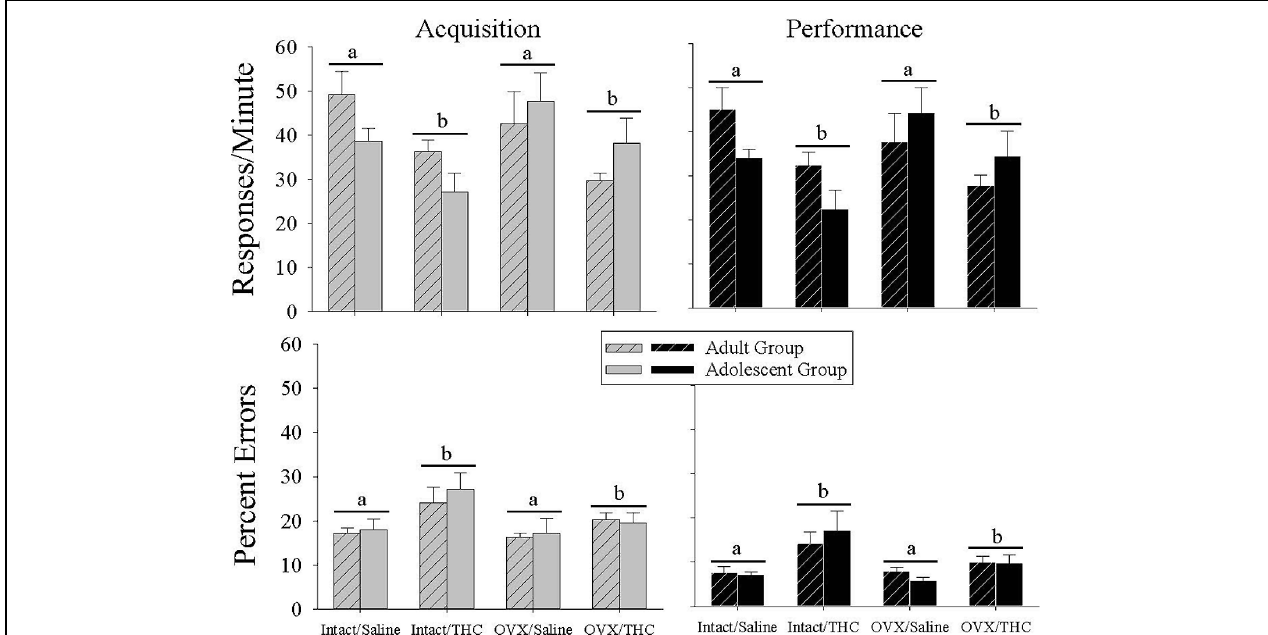
FIGURE 2 | Bar graphs showing the effects of hormonal status and chronic (cid:2) 9 -THC administration from either early adulthood ( n = 6/group) or adolescence ( n = 6/group) on baseline response rates and percent errors under the multiple schedule of repeated acquisition and performance of response sequences. These data represent the grand mean for 6–20 occasions in each subject when an injection of saline was